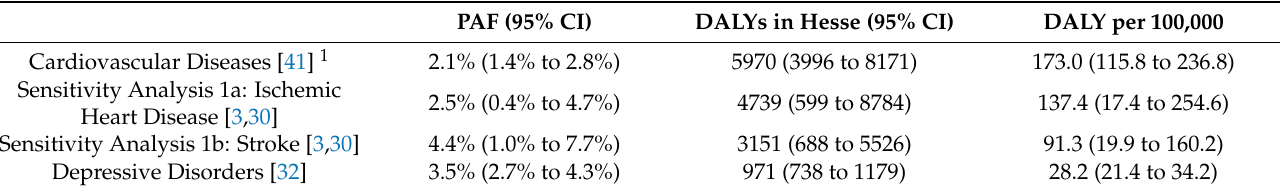
Table 4. The DALYs due to cardiovascular diseases and depressive disorders attributable to road-traffic noise in Germany and Hesse (people age ≥ 40 years). PAF (95% CI)